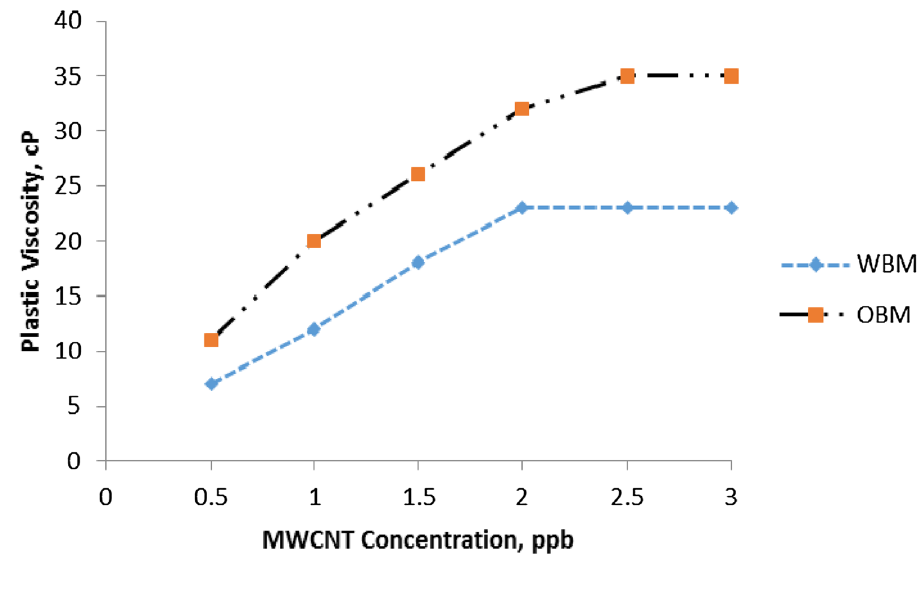
Fig. 3 Yield point at different concentrations of MWCNT for WBM and